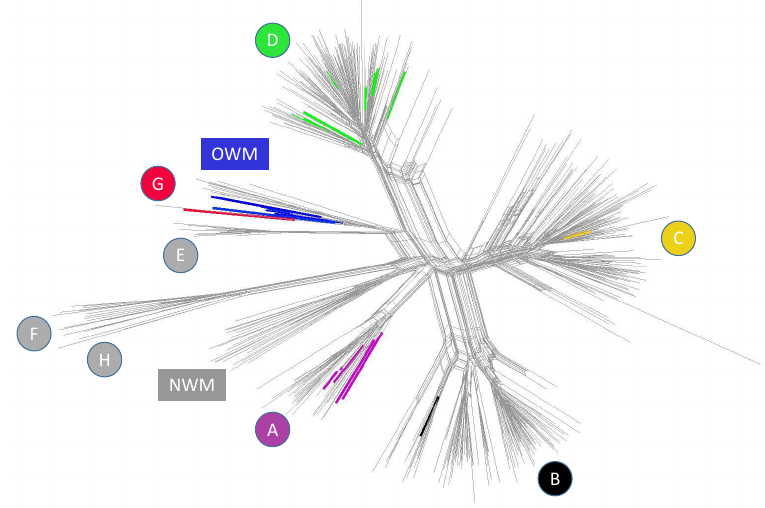
Figure 5. Network of 493 modern genomes, 15 published ancient strains and 12 newly-discovered ancient strains. Single letters indicate HBV genotypes (A–H); coloured strains are of ancient origin; OWM = Old-World Monkey HBV strains, NWM = New-World Monkey HBV strains. D: five new ancient strains, six ancient strains [43–45]; C: one ancient strain [46]; B: one ancient strain [45]; A: two new ancient strains, three ancient strains [45]; G: one new ancient strain; OWM: three new